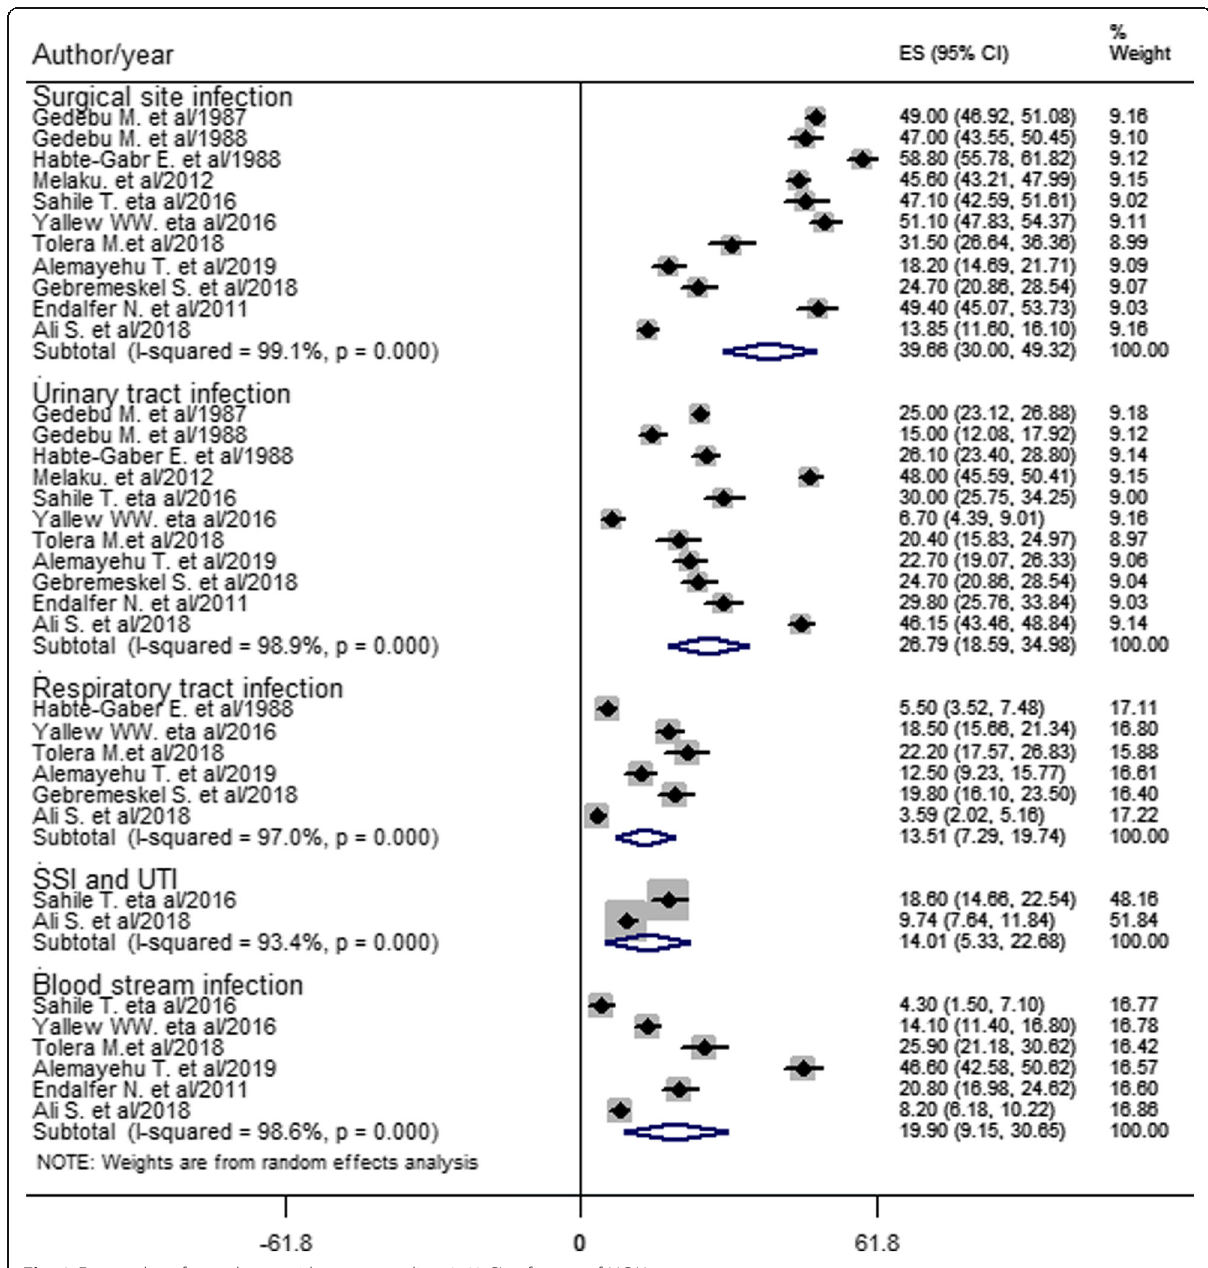
Fig. 3 Forest plot of prevalence with corresponding 95% CIs of types of